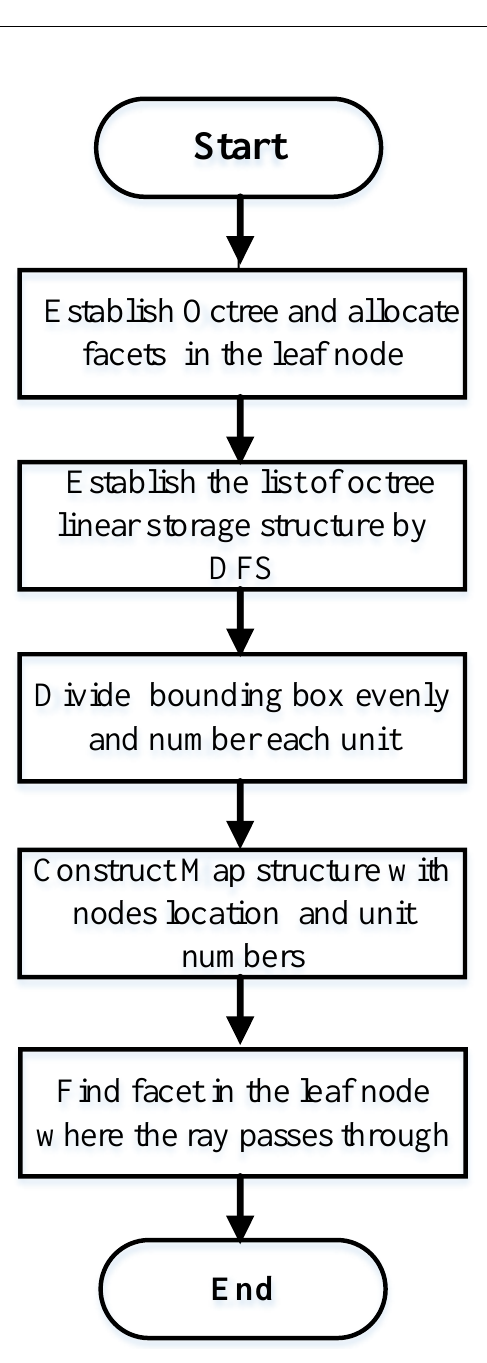
Figure 2. Flowchart of ray marching algorithm.